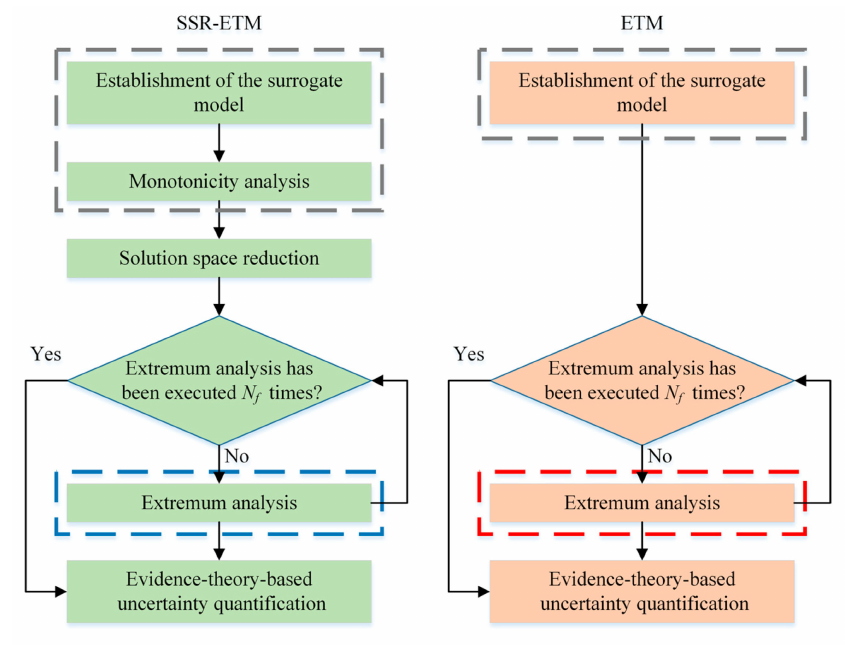
Figure 2. Framework of the SSR-ETM and